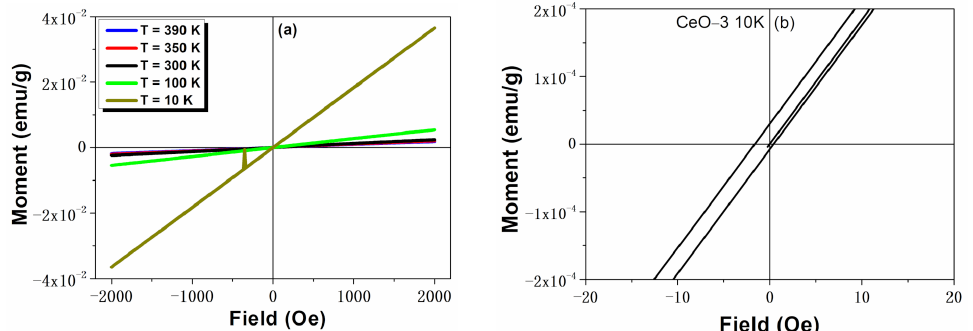
Figure 5. Magnetization curves of CeO-2 ( a ) at different temperatures, ( b ) in the low field region at 10